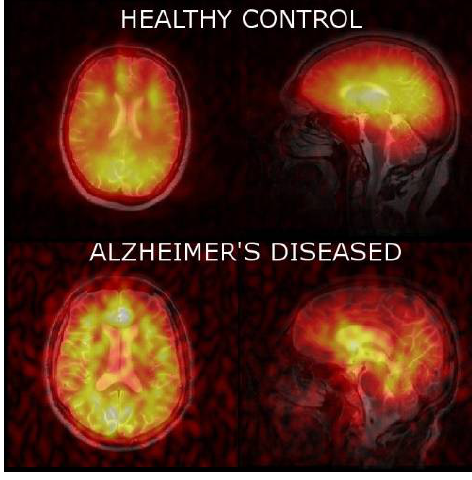
Figure 4. Axial and sagittal 129 Xe MRI of healthy controls and AD participants. An observably higher SNR was obtained for healthy controls relative to AD participants.